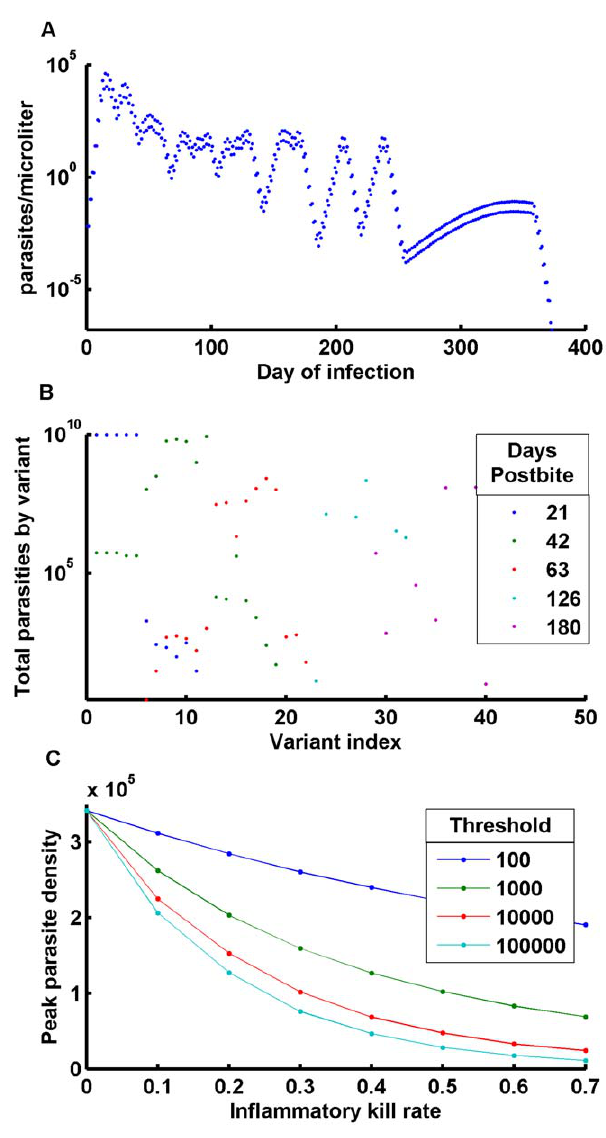
Figure 5. Sample infection with antigenic variation and the effect of inflammatory response. A) Sample infection with daily reports of IRBC/ m l; B) Change in the distribution of expressed variants over the course of infection;. C) Effect of innate immune effective threshold X 50,innate and inflammatory kill rate C innate on peak parasite